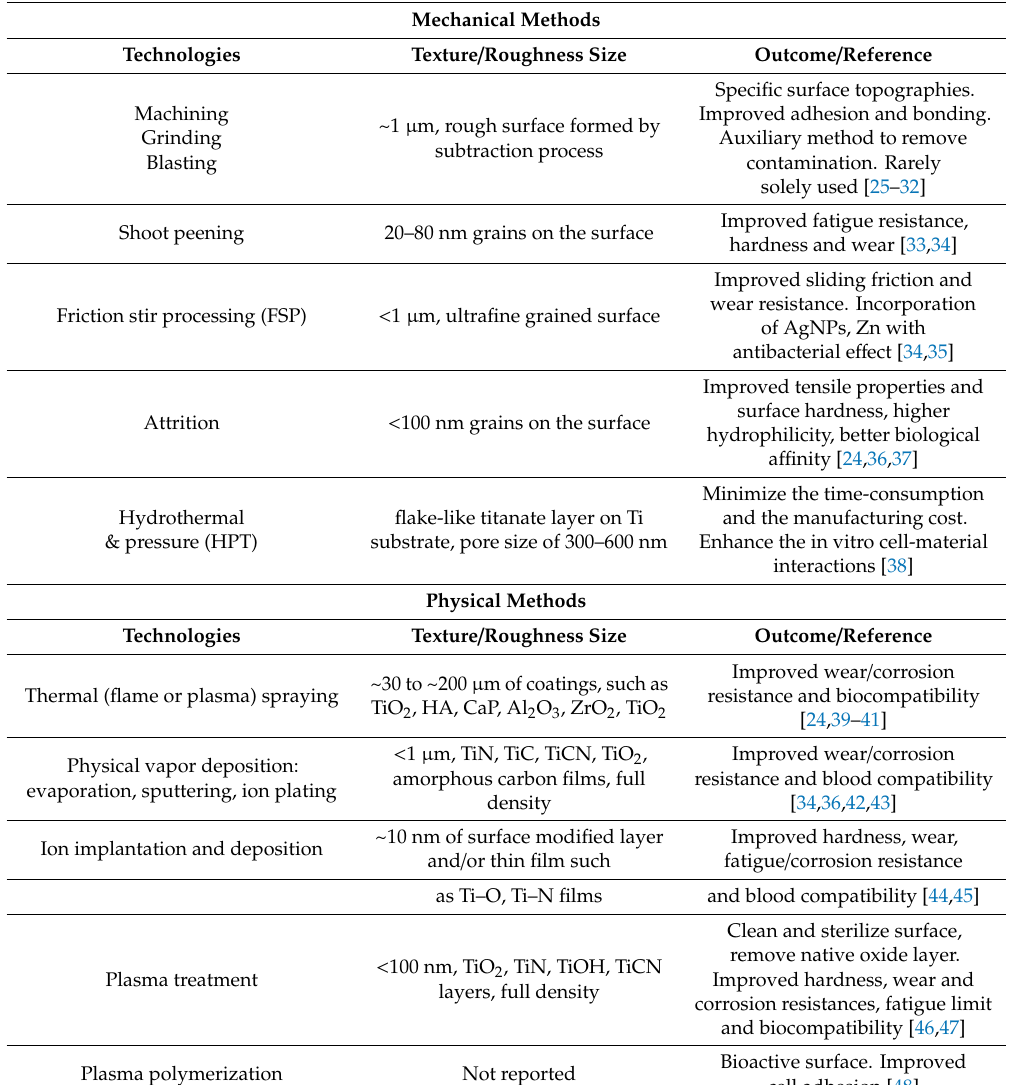
Table 1. Mechanical, physical and chemical methods used for surface modification of Ti implants for cranial and maxilofacial